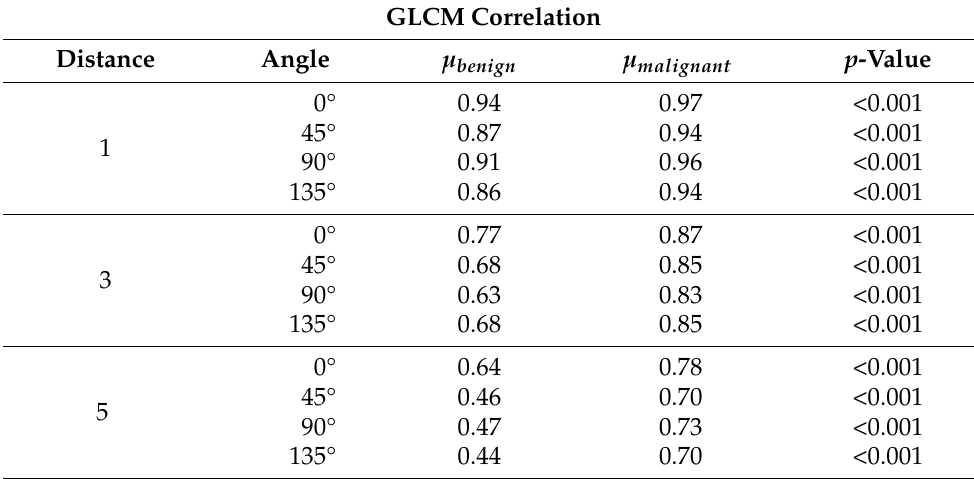
Table A4. The gray level co-occurrence matrix correlation feature measured across three